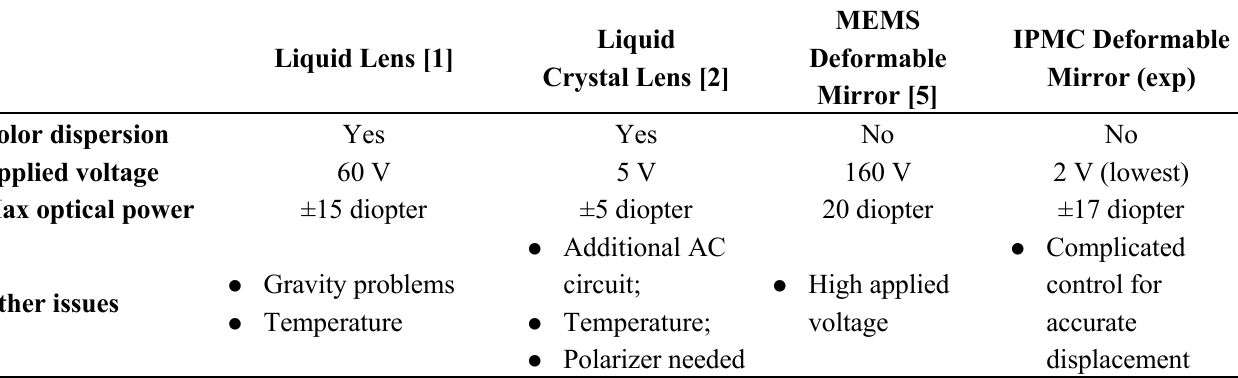
Table 2. Comparison between different